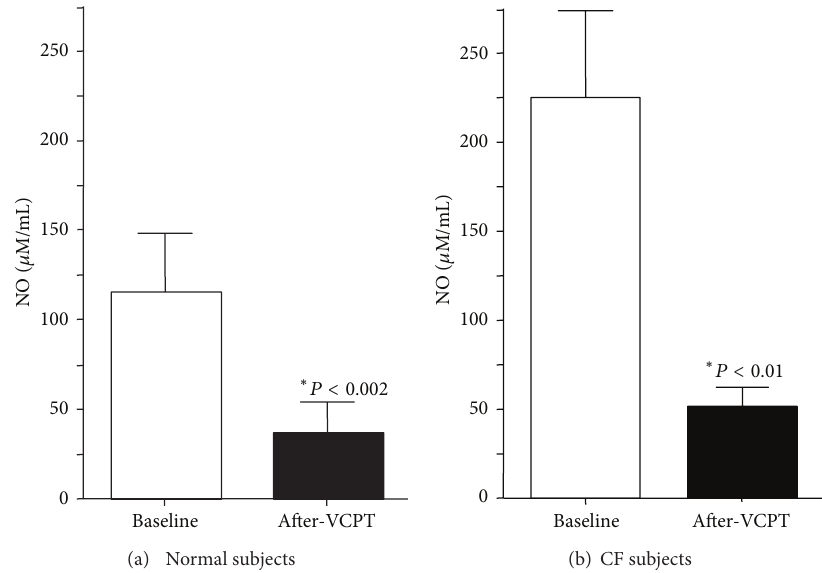
Figure 5: Aggregate exhaled breath condensate oxides of nitrogen following VCBT. (a) EBC NO 𝑥 concentrations decreased 68% in control subjects after VCPT compared to baseline, pretreatment values (baseline= 115 ± 32 𝜇 M versus post-VCPT = 37 ± 17 𝜇 M ; 𝑃 < 0.002 ). (b) CF subjects showed a significant decrease in EBC NO 𝑥 after vest percussion treatment (baseline= 224 ± 55𝜇 M versus post-vest = 52 ± 11𝜇 M ; 𝑃 < 0.01